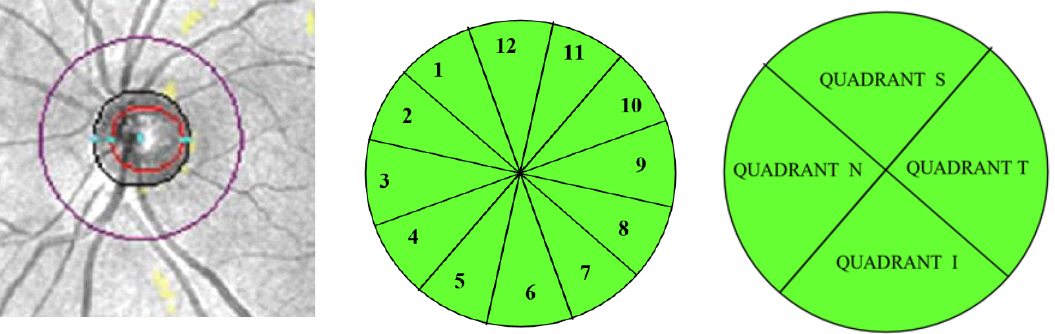
Figure 2. Peripapillary retinal nerve fiber layer was measured at the indicated purple circle ( left ). Clock-hour sectors ( center ) and quadrants ( right ) are represented. S = superior, N = nasal, T = temporal, I = inferior.